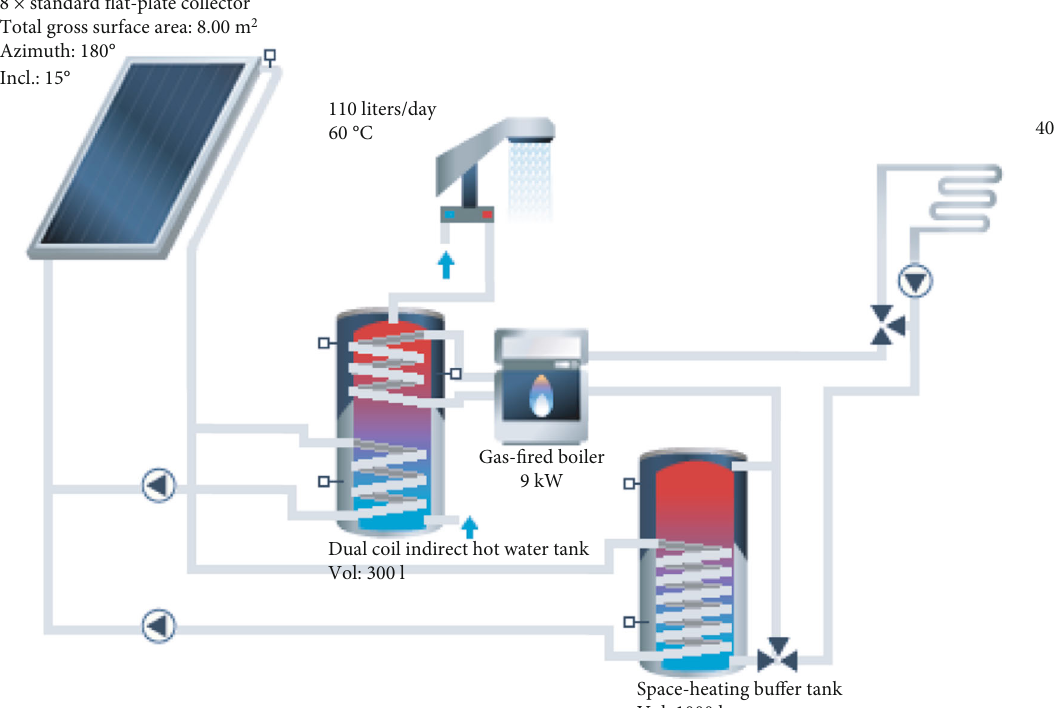
Figure 7: The speci fi cations and components of the simulated